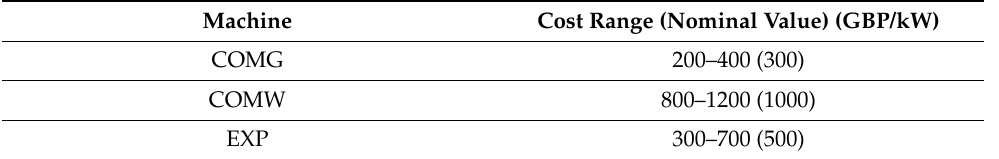
Table 3. Per-unit power capital costs for the compressor/expander machinery. Based on values in [2,13,38–40].